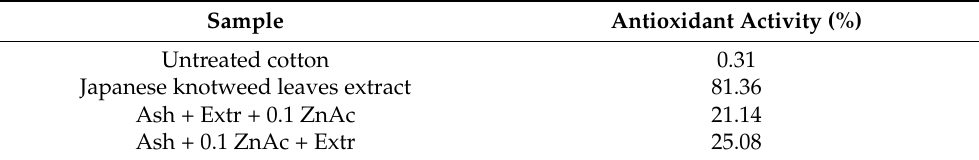
Table 2. Average antioxidant activity (%) of the untreated cotton sample, Japanese knotweed extract and cotton samples functionalised using Ash + Extr + 0.1 ZnAc and Ash + 0.1 ZnAc + Extr